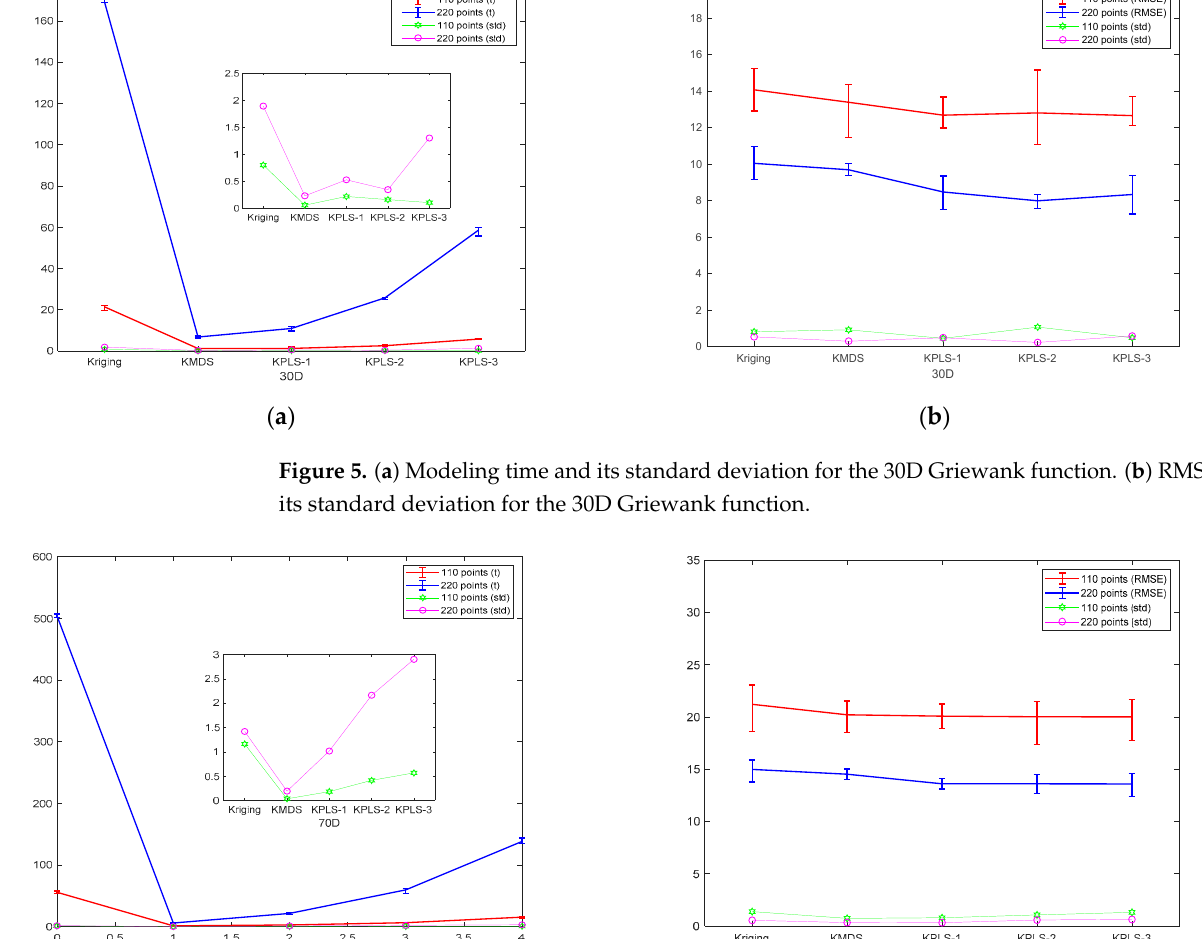
The red and blue curves in Figures 5 and 6 are error bar graphs for the ten test results. The point on the solid line is the average of the test results of each method. The upper end of the error bar is the maximum value of the test result of each method. Similarly, the lower end of the error bar is minimum of the test result of each method. The green and purple curves are the standard deviations of ten tests with different methods. Compared with Kriging, KPLS-1, KPLS-2 and KPLS-3, the proposed method uses the least modeling time, and the error accuracy obtained is not much different from that of KPLS1, KPLS-2 and KPLS-3, which is exactly what we expect. Moreover, the standard deviation chart also reflects the stability of the proposed method.